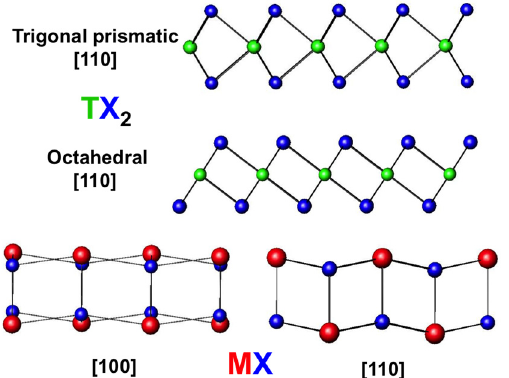
Figure 7. Structure types observed for TX 2 layers. Compounds based on Ti and V are octahedrally coordinated, and those based on Ta and Nb are trigonal prismatically coordinated. The rocksalt like structure is also shown, with puckering distortions in the c